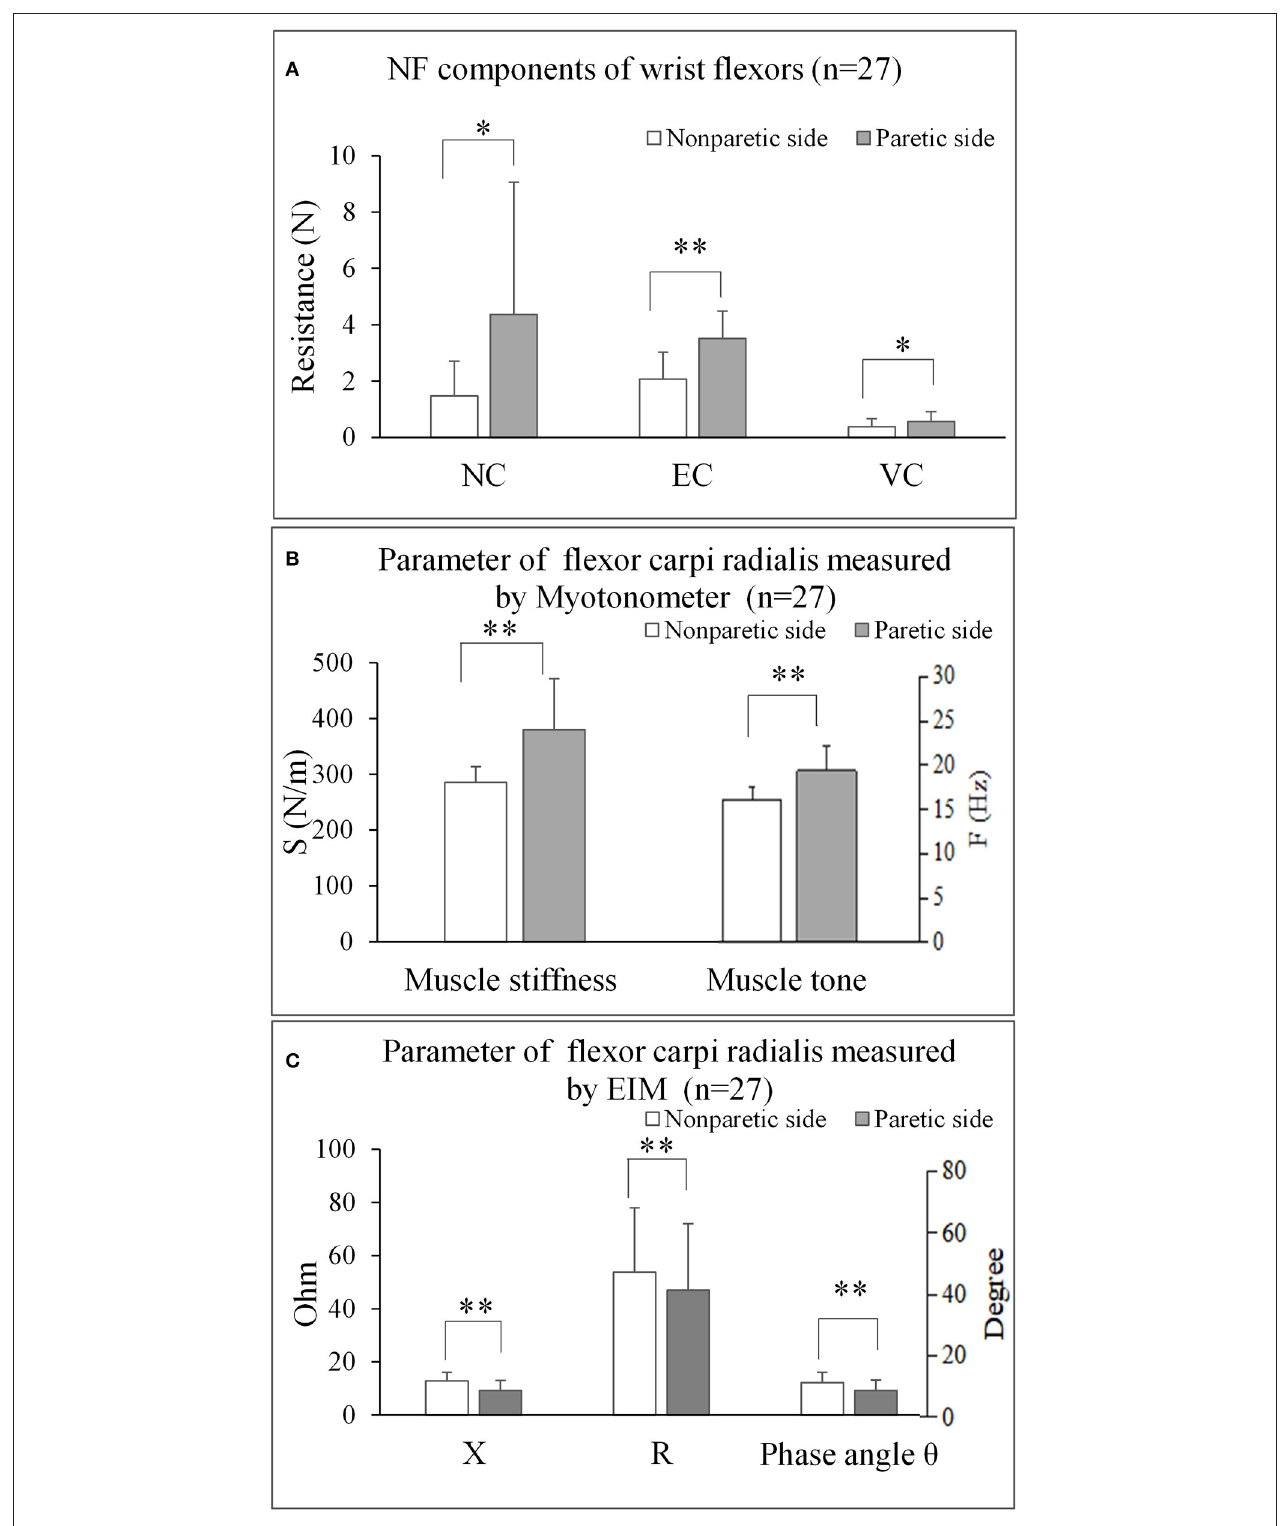
FIGURE 3 | The comparisons of bilateral parameters for each measuring techniques. (A) NF components of wrist flexors ( n = 27). (B) Parameter of flexor carpi radialis measured by Myotonometer ( n = 27). (C) Parameter of flexor carpi radialis measured by EIM ( n = 27). NF, NeuroFlexor; NC, Neural Component; EC, Elasticity Component; VC, Viscosity Component; S, Stiffness; F, Frequency; EIM, Electrical impedance myography; X, Reactance; R, Resistance. * P < 0.05; ** P < 0.001.